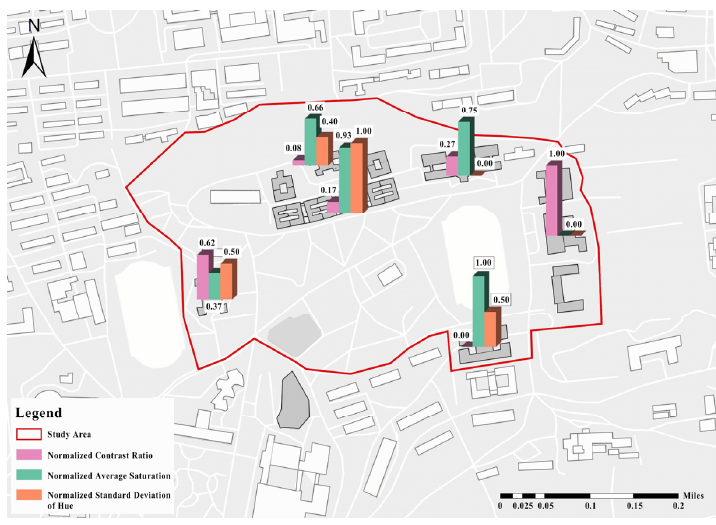
Figure 6. Analysis of landscape colors.